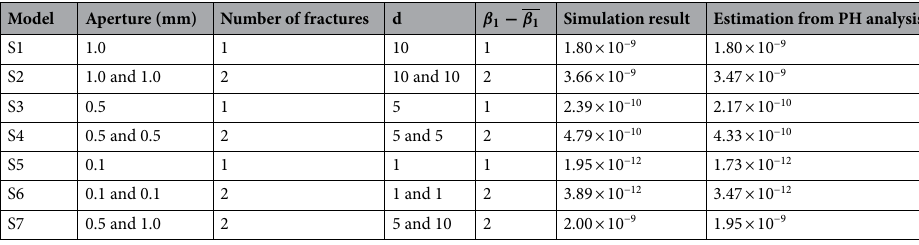
Model Aperture (mm) Number of fractures d